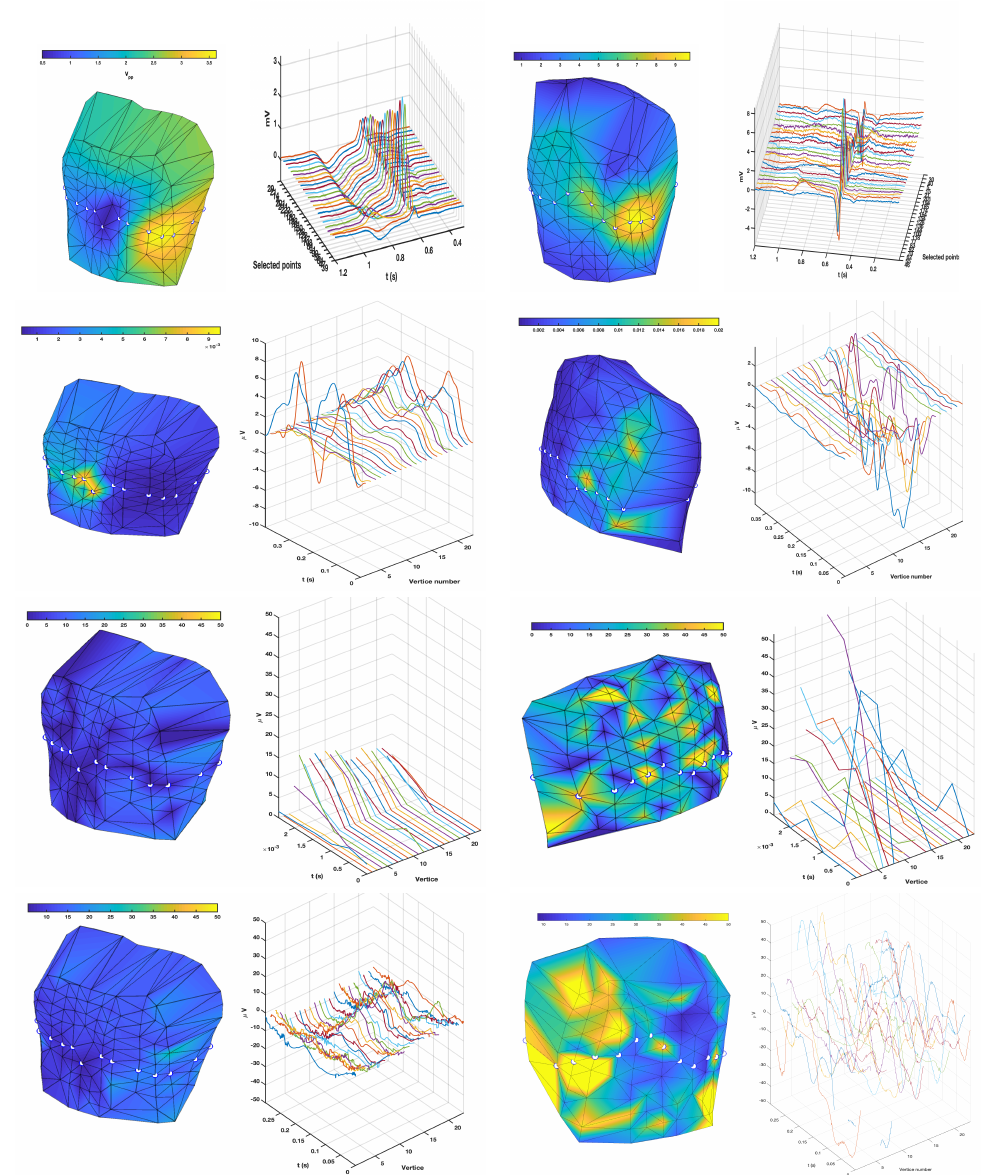
Figure 8. Analysis of T-wave alternans (TWA) detection algorithms in Torso recordings, for control subject ( left ) and Long-QT syndrome (LQTS) patient ( right ). The first row shows the voltage maps and M-mode for EGMs on the path in white points. The second, third, and fourth rows show the maximum amplitude maps and the TWA estimation provided by the temporal estimation, by the spectral method, and by the Modified Moving Average (MMA) method, respectively. The M-modes and colorbars are adapted to give a better understanding of the results. Note that these are not EGM potentials, but instead estimation of alternans amplitudes (in the temporal method) or of its measurement though some closely related index (spectral and MMA methods). The alternans amplitudes change spatially and temporally smooth in the control subject, whereas they exhibit noticeable spatial and temporal fluctuations in the LQTS patient. The line of points for the M-mode was selected to follow significant changes in the EGM amplitudes, and hence being able to check that the alternan’s changes in amplitude were not just an echo of the EGM changes in